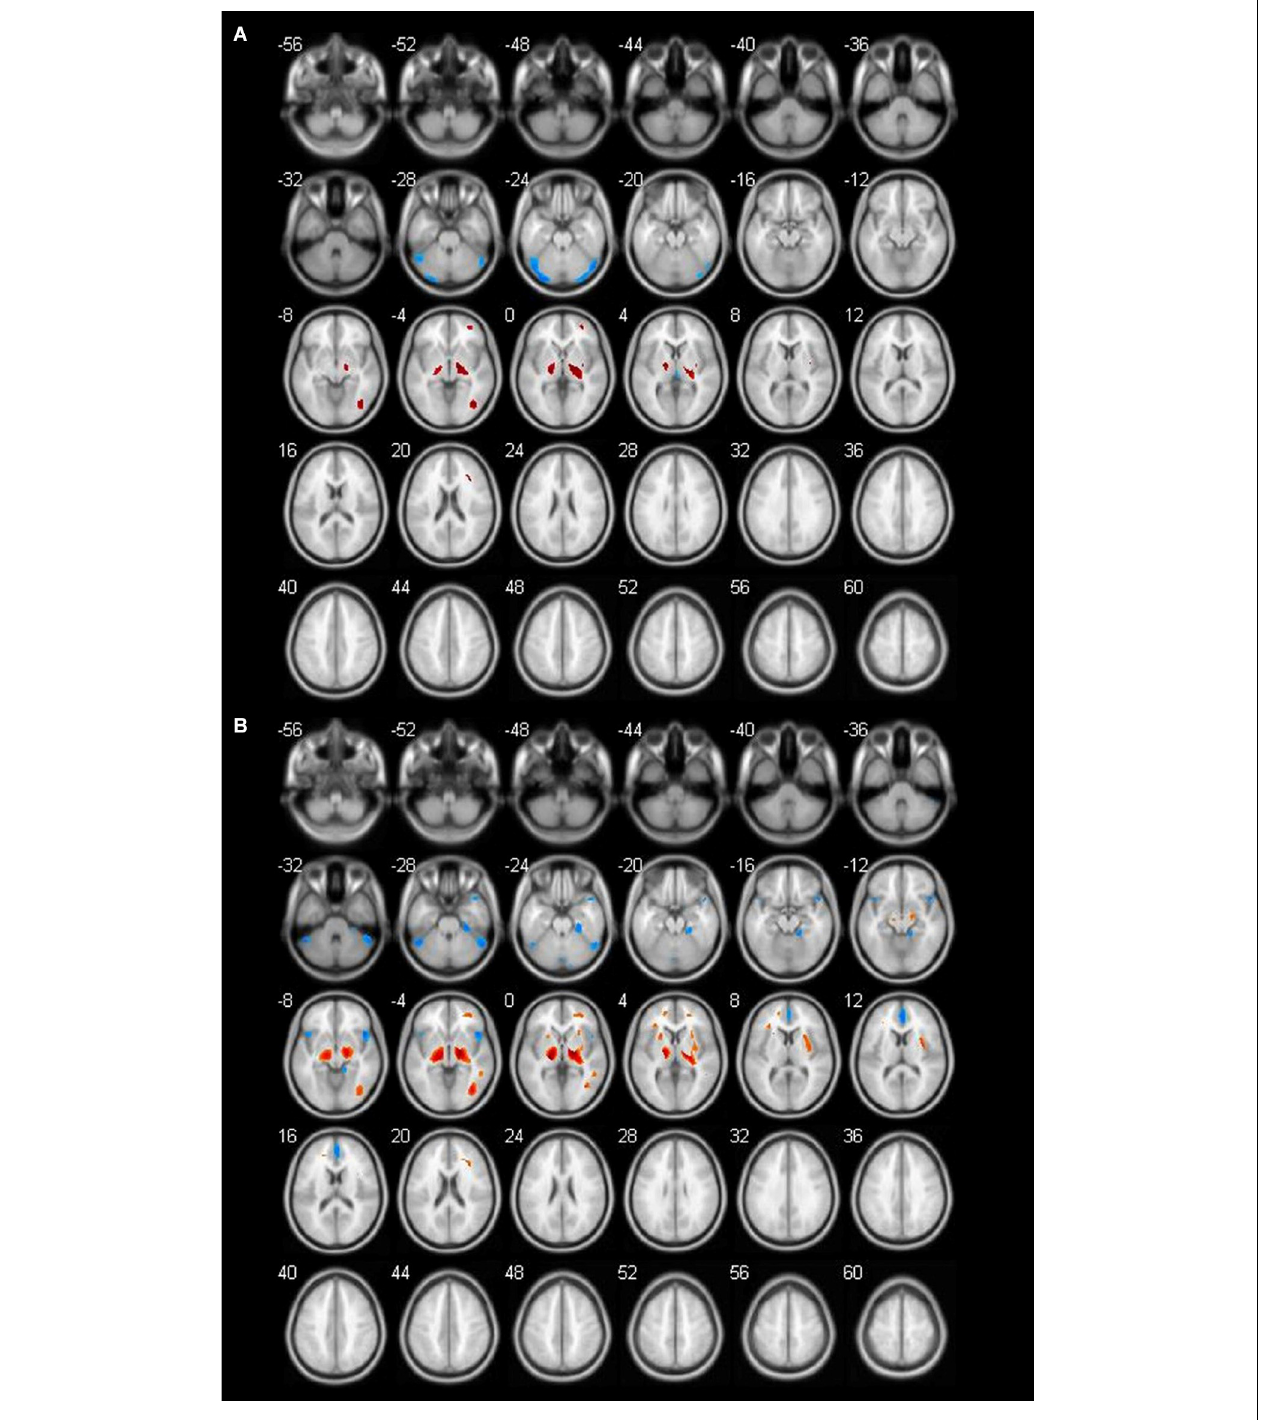
FIGURE 3 | Different brain regions in female groups (blue indicates decrease; red indicates increase). (A) Female 60–69 age group; (B) female 70–89 age group.